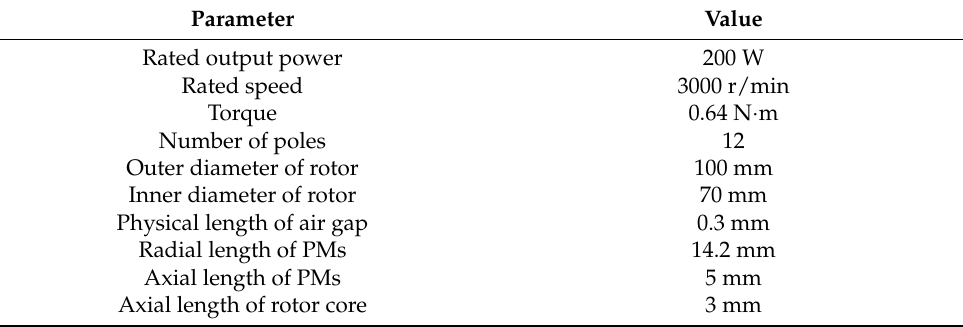
Figure 1. Basic structure of proposed AFPM machine with a coreless stator: (1) stator armature; (2) shell; (3) bearing; (4) rotor core; (5) PMs; (6) reinforcement sheet; (7) stator support. Table 1. Fundamental parameters of coreless AFPM